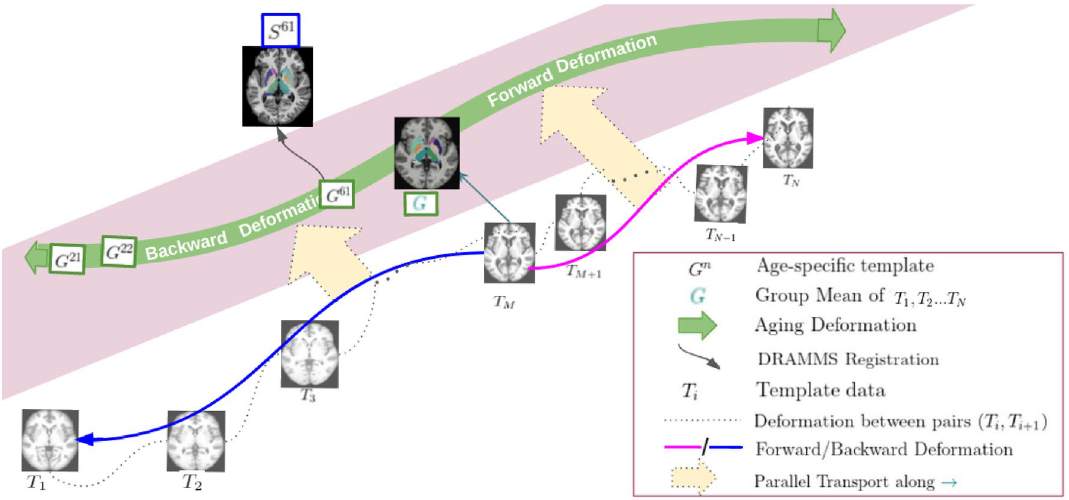
Figure 1. A schematic representation of the aging model. Included is an illustration of how the model maps a subject scan at age = 61 years to the global